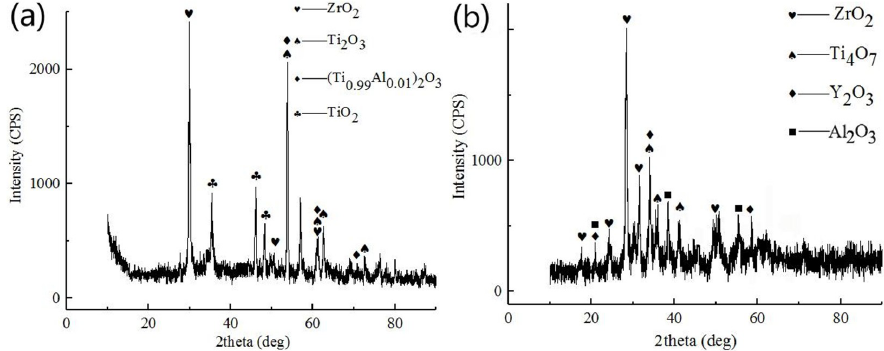
Figure 8. XRD patterns of the specimens at 800 °C for 100 h: ( a ) Zr coating; ( b ) Zr-Y coating.